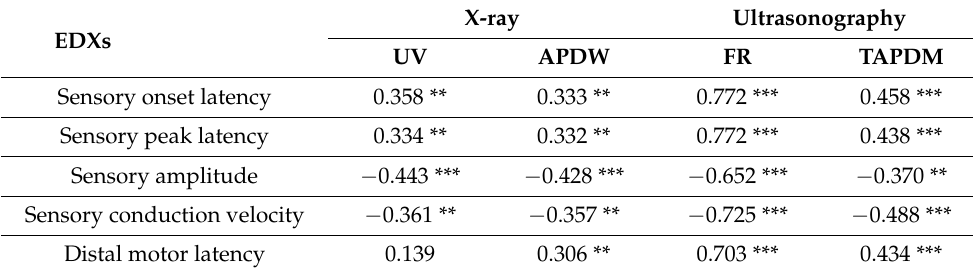
Table 3. Pearson’s correlation coefficients between electrodiagnostic parameters and imaging